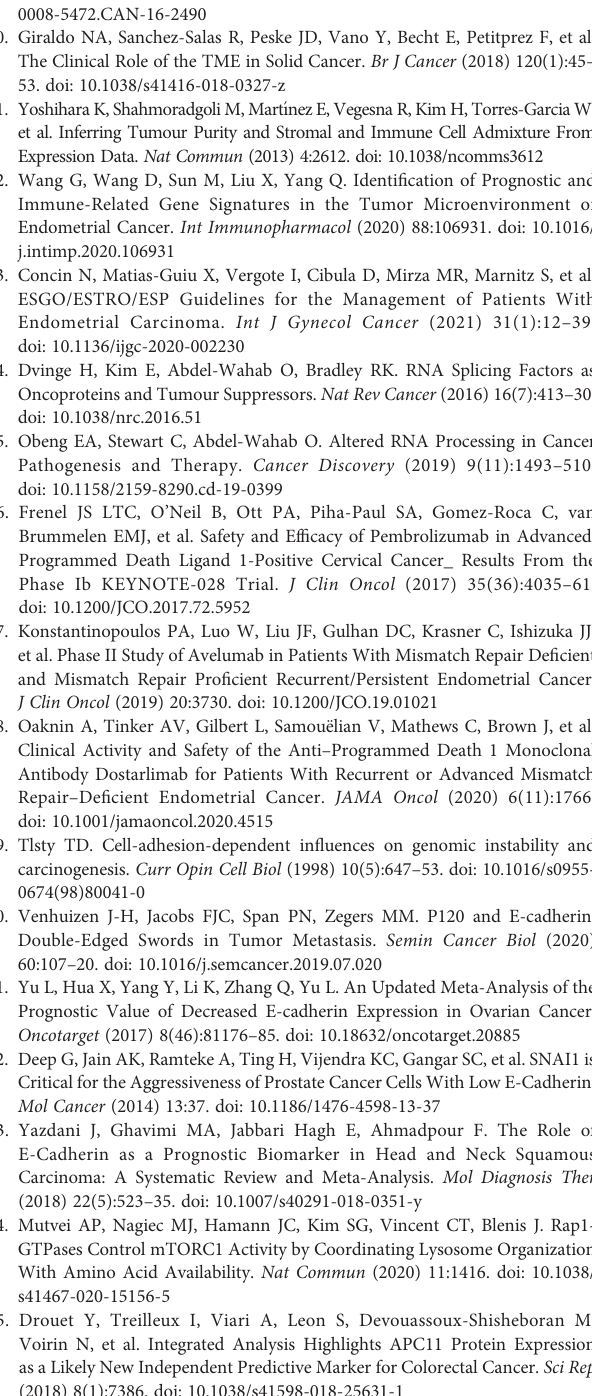
Supplementary Table 1 | The clinical information of the EC patients. Supplementary Table 2 | The stromal/immune scores of EC patients from TCGA database. Supplementary Table 3 | The information of 148 OS-related DEAS events by univariate Cox regression